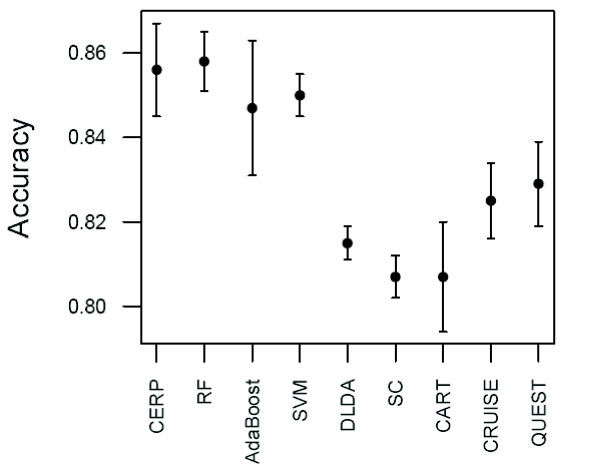
Accuracy of classification algorithms for the van de Vijver et al. [17] data.